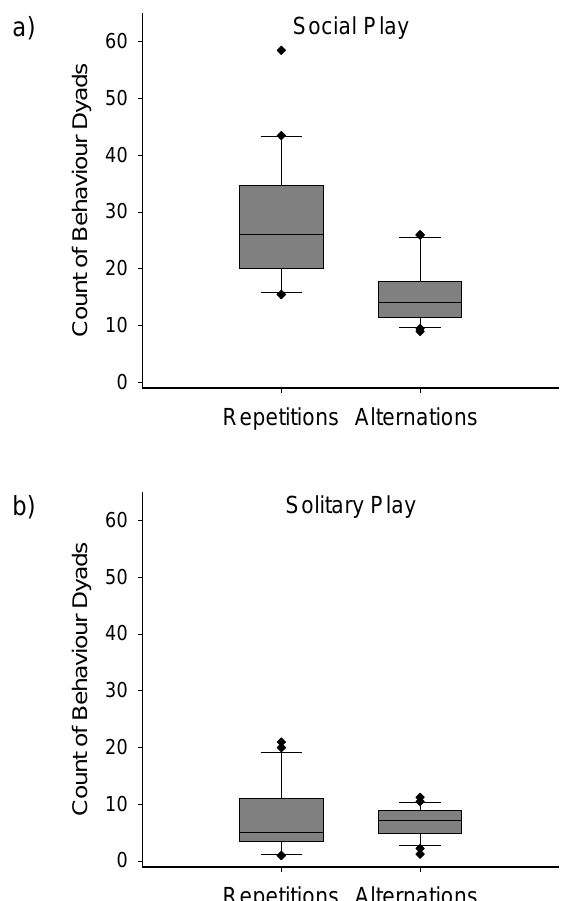
Figure 2 . Frequencies of a) repetitions and alternations of social play behaviors (Pinning/Being Pinned) and b) repetitions of solitary play (Scampering) and alternations between solitary and social play